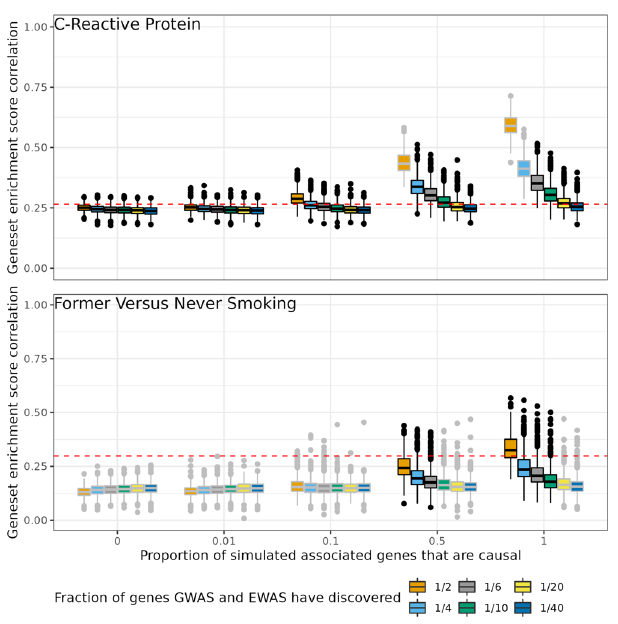
Fig.4|Simulationstounderstandthelikelynumberofgenesstilltoidentifyin GWASandEWASofC-reactiveproteinandsmoking(formervs.neversmokers) under different trait architectures. Simulations were set up as illustrated in Supplementary Fig. 4. Correlation of geneset enrichment scores from empirical data (Table 3), is shown as a red dashed line. Box plots show the range of enrich- ment score correlations from 1000 simulations using the parameters indicated. The number of causal and associated genes, as well as the number of associated genesthatwerecausalwerevaried.AlreadydiscoveredEWASgeneswereaddedto the pool of associated genes and already discovered GWAS genes were added to the pool of causal genes. The proportion of simulated associated genes that were causal is shown on the X -axis. The number of causal genes and associated genes wereequalineachsimulation.Scenarioswhichlieclosetotheempiricalresult(red dashed line) are more likely to re fl ect the true underlying number of genes related to a trait and the true overlap between the causal and associated genes. Where thereisevidence that on average the geneset enrichment scoresfrom asimulation scenario are different to the empirical enrichment score (FDR<0.05, z-test for difference),theboxoutlineisgrey,otherwiseitisblack.Thecentreoftheboxplots are the median, the bounds of the box represent the interquartile range (IQR), the upper whisker represents either the minimum of (1.5 multiplied by the IQR) + the 75%percentileandthemaximumvalue,thelowerwhiskerrepresentsthemaximum of 25% percentile − (1.5 multipliedby the IQR) and the maximum value. Values that fall outside the whiskers are marked as